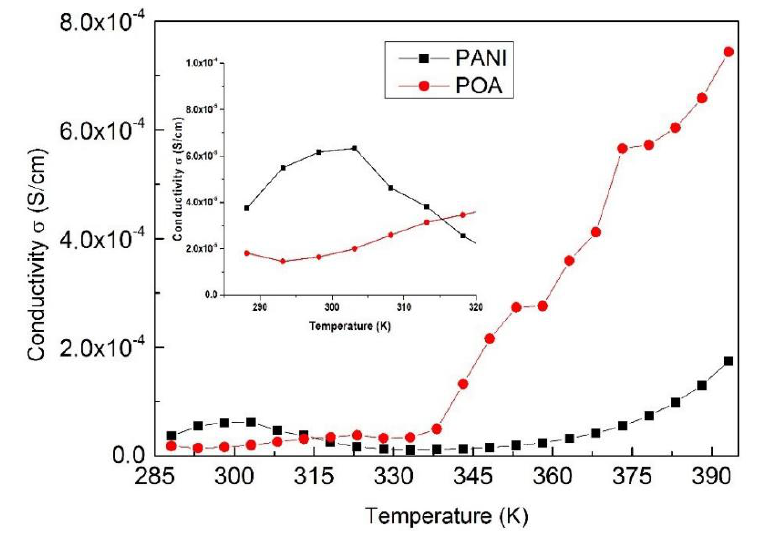
Figure 12. Dependence of PANI 8 and POA samples’ electrical conductivity on temperature.